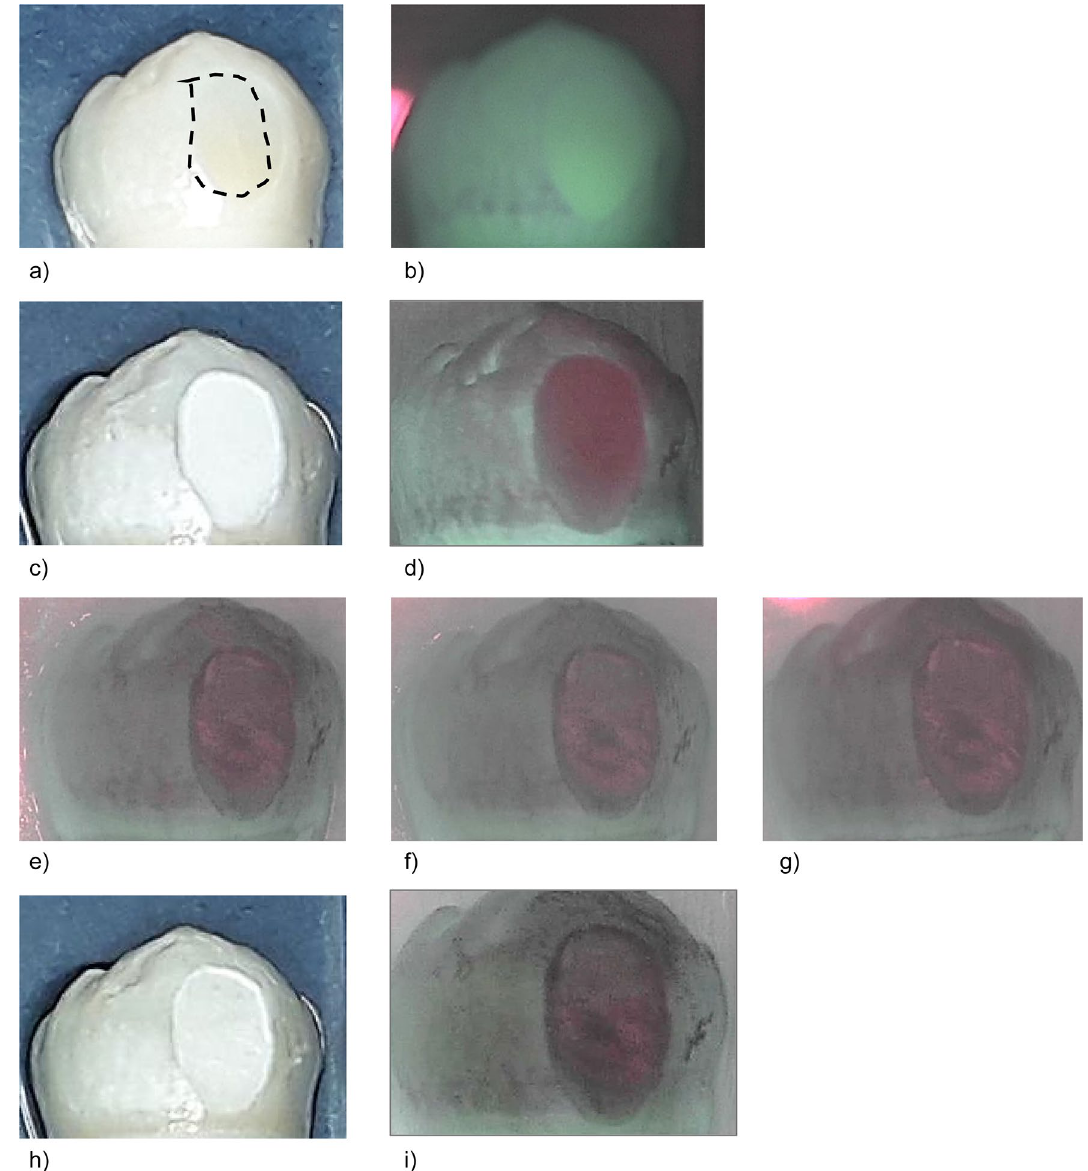
Figure 1. Standard image and QLF image of a representative sample in group I (SDF, sample #05) at different investigation times. The dashed line indicates the ground surface where the QLF measurements were performed. ( a ) Prior to demineralization. ( b ) Corresponding QLF-image: ΔF = 0.0%; ΔFmax = 0.0%. ( c ) After demineralisation (T-demin). ( d ) Corresponding QLF-image (T-demin): ΔF = − 17.0%; ΔFmax = − 34.1%. ( e ) QLF image T07: ΔF = − 12.2%; ΔFmax = − 28.6%. ( f ) QLF image T14: ΔF = − 12.8%; ΔFmax = − 30.2%. ( g ) QLF image T21: ΔF = − 11.5%; ΔFmax = − 33.3%. ( h ) 28 days after demineralisation (T28). ( i ) Corresponding QLF- image (T28): ΔF = − 14.5%; ΔFmax = −